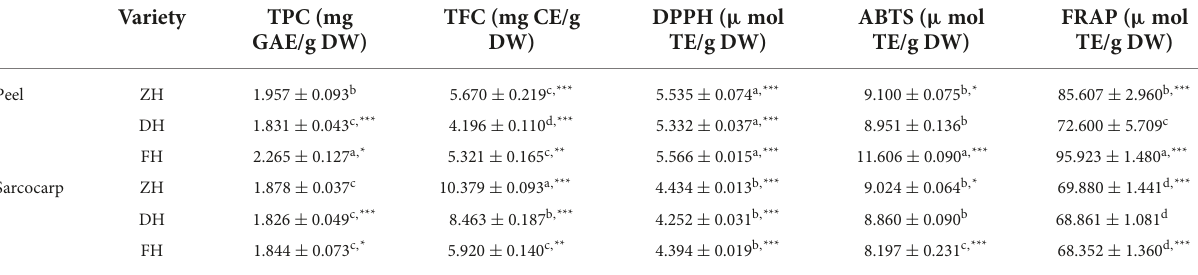
TABLE 2 Content of TPC and TFC and antioxidant activity of Kadsura coccinea before digestion.